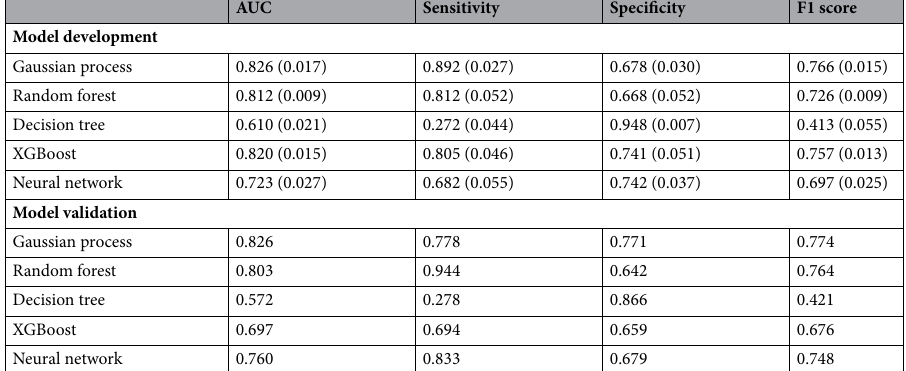
Table 4. 4 + RBCs transfused classification. Multiple machine learning (ML) models were compared using several performance metrics. Our Gaussian Process (GP) classification model demonstrated the best performance in the development phase and in the subsequent validation phase. AUC area under the receiver operator curve. F1 Score = the harmonic mean of the sensitivity and positive predictive value. Note that standard deviations are only listed for the model development phase that used the initial dataset because it used five-fold cross validation. The model validation phase used the initial dataset for training (n = 2410) and the additional set of cases (n = 437) for its test phase.